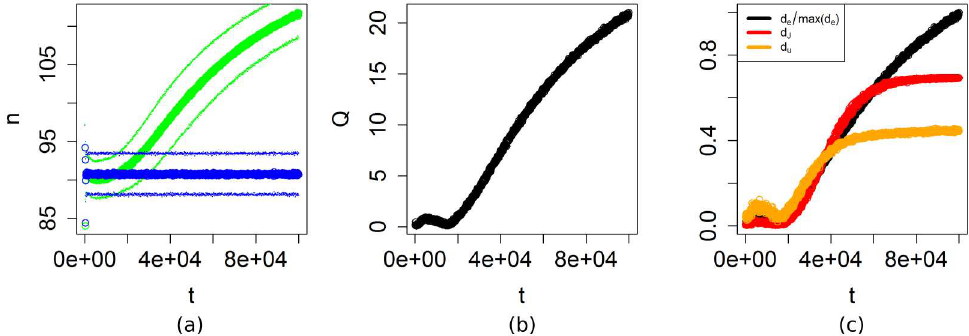
Fig 7. Effects of adaptation. (a): Means of the pdfs P a ( green )and P b (blue) at the default parameter settings. The thinner lines show the mean plus or minus one standard deviation. Both the mean and standard deviation were estimated based on 1000 replicate runs. (b): Plot of Q betweenthe pdfs P a and P b , as functions of time. The plot shows that on long time-scales the effects of adaptation increase. (c): Comparison betweenthe earth- mover’s distance d e (black), the Jensen-Shannondivergence d J (red), and the Euclidian distance d E (orange).To fit in the same graph, we plot d e dividedby its maximimumvalue. For large values of t , d J and d u become insensitiveto changesin the pdfs when there is no longeroverlap betweenthe pdfs. In contrast, d e continuesto